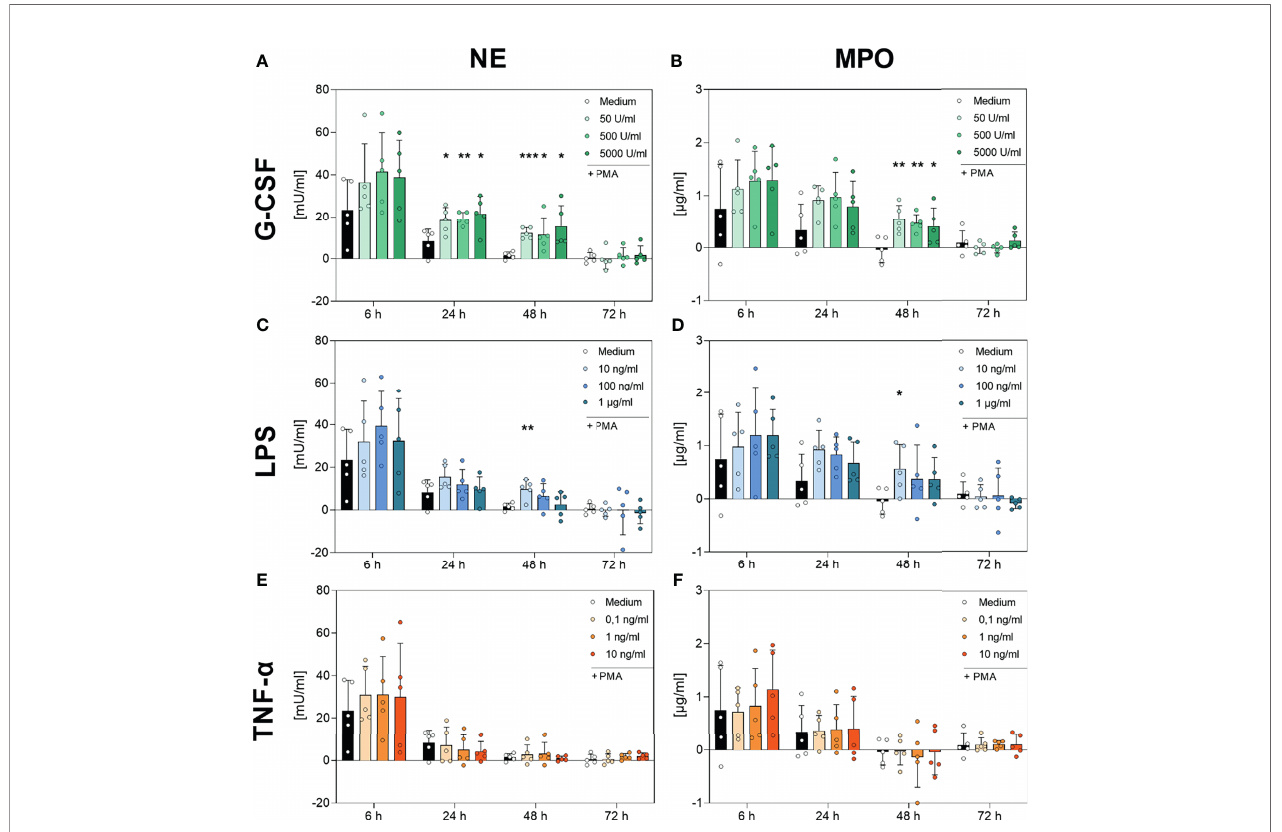
FIGURE 8 | Analysis of NE- and MPO-activity in PMA-induced NETs after incubation with G-CSF, LPS or TNF- a . Neutrophils were incubated with G-CSF (A, B) , LPS (C, D) , TNF- a (E, F) or medium only and stimulated with 20 nM PMA at the indicated timepoints. Neutrophil elastase (left panel) and myeloperoxidase (right panel) activities were measured using the absorption with a plate-reader (405 nm for NE, 650 nm for MPO) and normalized to a standard. Values represent means ± SD of n = 5. Differences between the untreated control group and one treated group each were calculated individually using the student ’ s t-test. Levels of signi fi cance were set at < 0.05 (*), < 0.01 (**), < 0.001